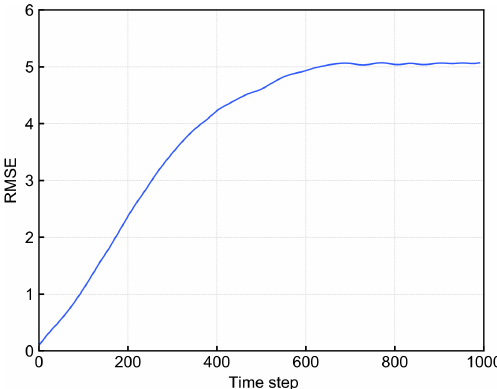
Figure 5. The mRMSE time series of the predictions of RC-Obs with perfect observation. Horizontal axis shows the time step and vertical axis shows the value of